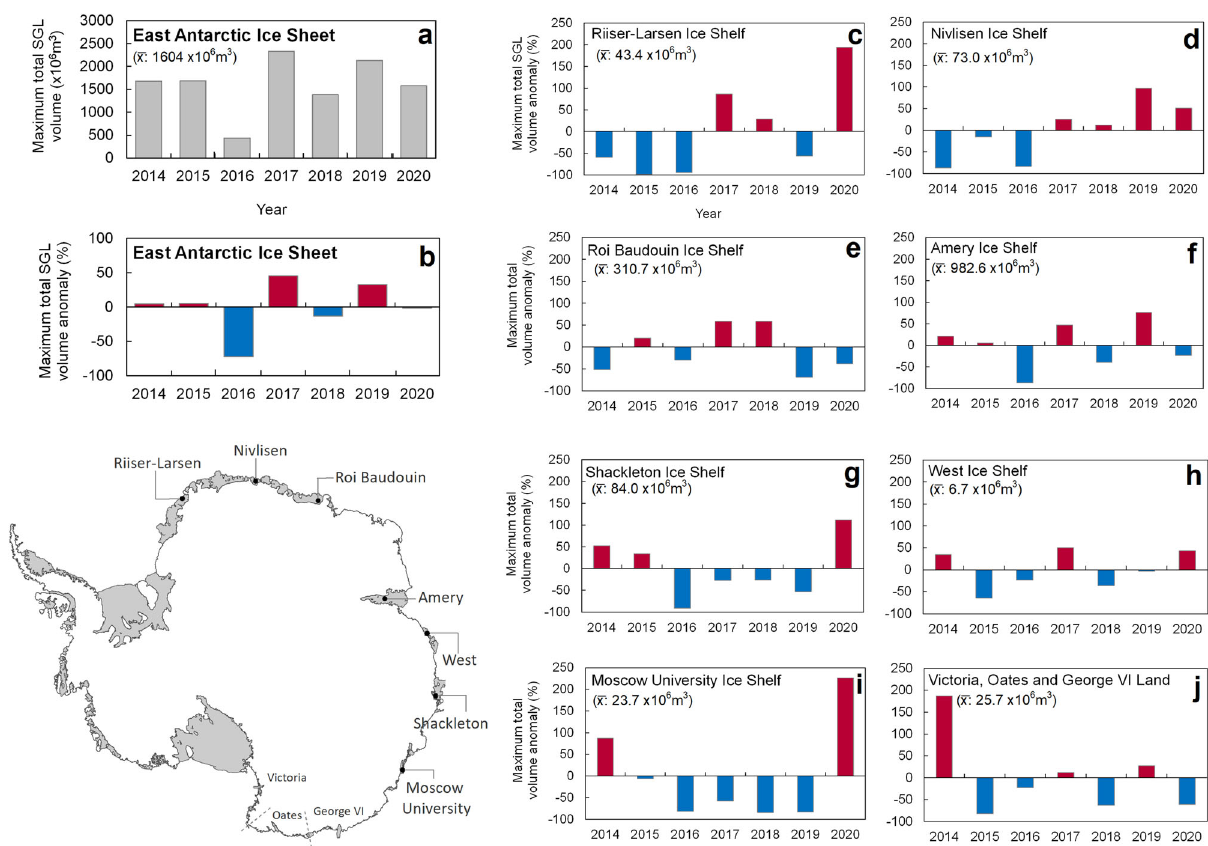
Fig. 2 Interannual changes in supraglacial lake volumes on the East Antarctic Ice Sheet. a Absolute total SGL volumes (in millions of cubic metres) on the East Antarctic Ice Sheet. b Percentage SGL volume anomalies (i.e. percentages of the mean 2014 – 2020 maximum total lake volume) on the East Antarctic Ice Sheet. c – j Percentage SGL volume anomalies (i.e. percentages of the mean 2014 – 2020 maximum total lake volume) on selected major ice shelves and regions. Positive anomalies are shown in red and negative anomalies are shown in blue. See Supplementary Fig. 3 for anomalies as standard deviations. The absolute mean maximum total SGL volume (x ̄ ) is shown in panels a and c – j . Supraglacial lake volume anomalies for two addition regions, the Ingrid Christensen Coast and Voyeykov Ice Shelf, are shown in Supplementary Fig. 4 rather than this fi gure because lakes occur with less frequency in these two regions. Grounding line from ref. 77 and coastline from ref. 78 .